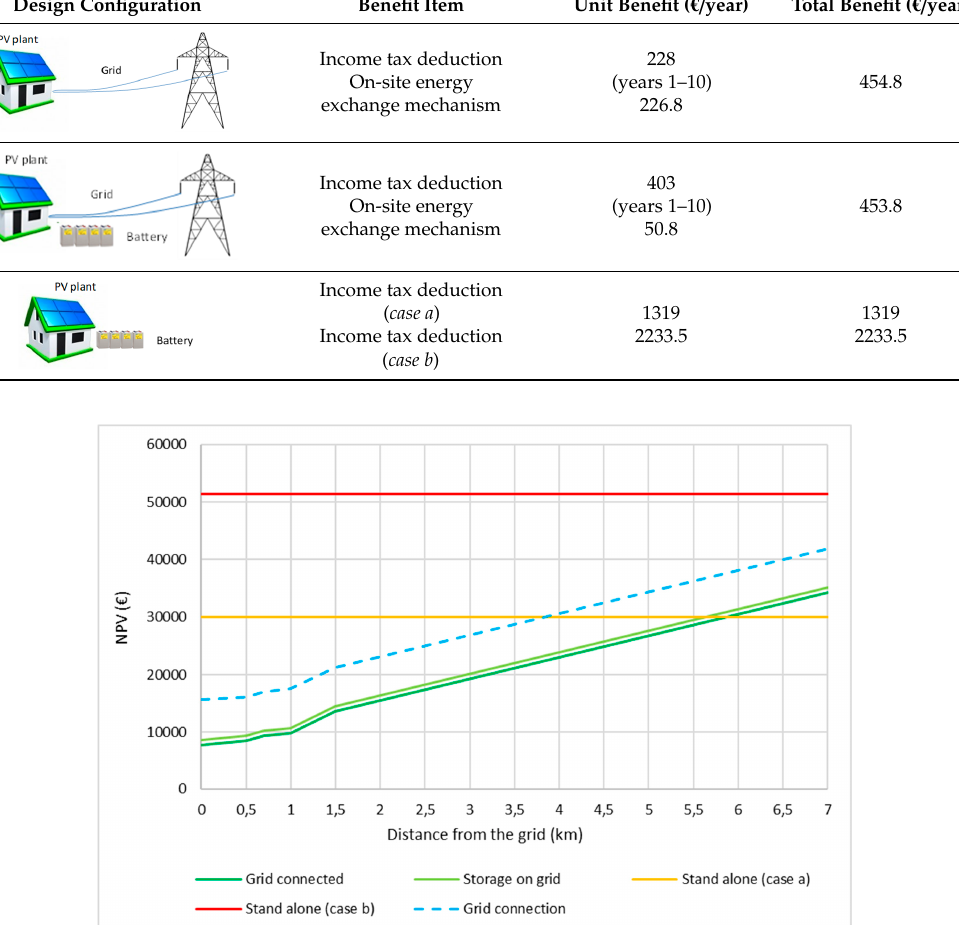
Table 6. Emission factors, reproduced from [76], ISPRA 2018.